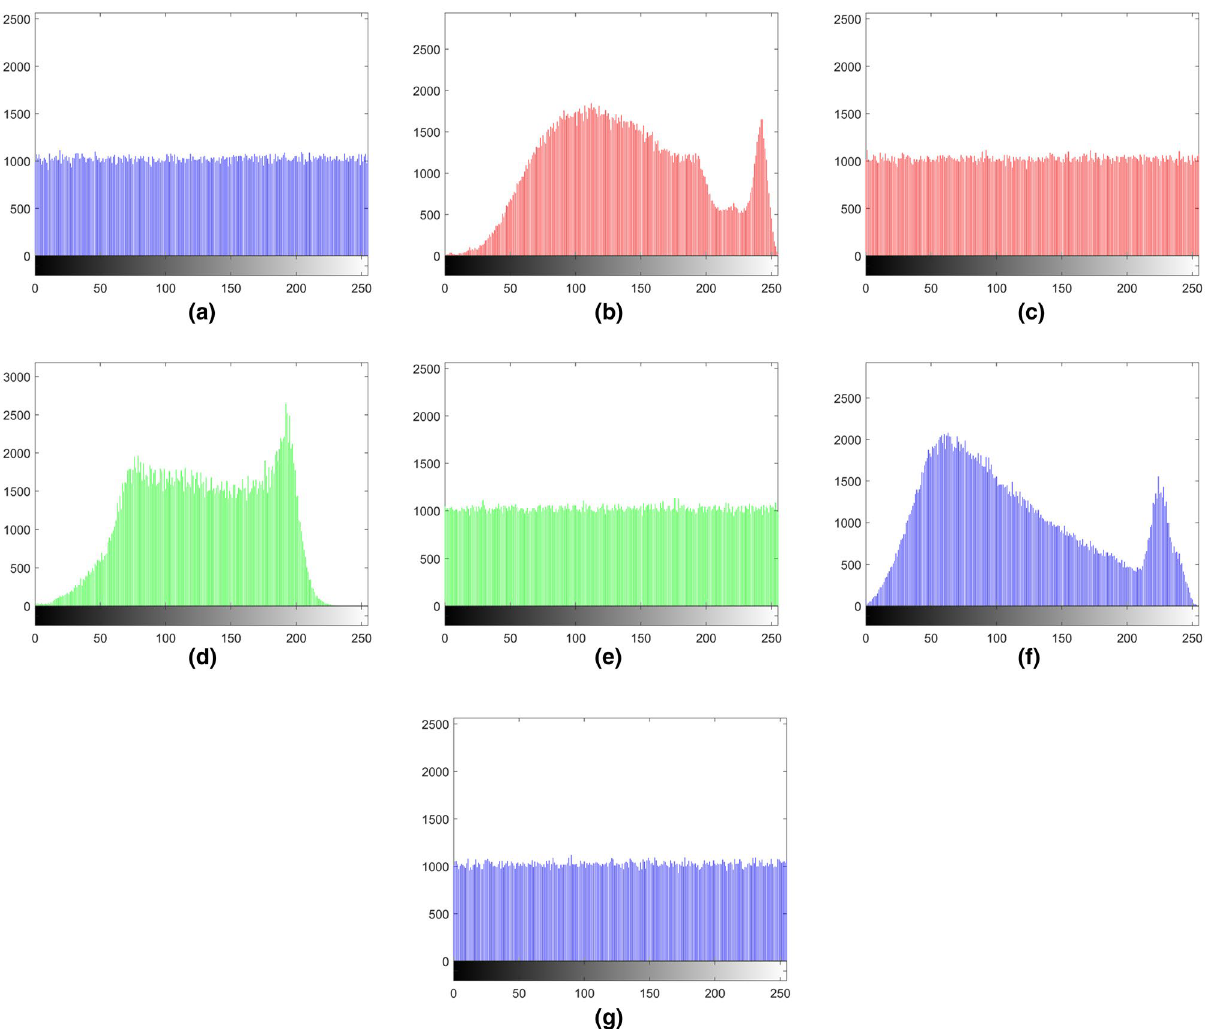
Figure 14. The histograms of the encrypted binary image, color image and encrypted color image. ( a ) Histogram of encrypted Binary_boat.512, ( b ) histogram of R channel of color image 4.2.03, ( c ) histogram of R channel of encrypted color image 4.2.03, ( d ) histogram of G channel of color image 4.2.03, ( e ) histogram of G channel of encrypted color image 4.2.03, ( f ) histogram of B channel of color image 4.2.03, ( g ) histogram of B channel of encrypted color image 4.2.03.